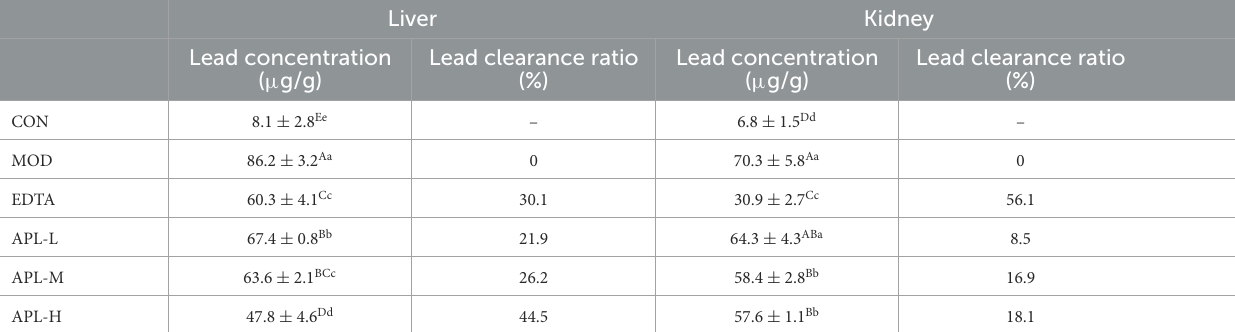
TABLE 3 APL-elicited inhibition of rise in lead concentration and increase of lead clearance ratio in the liver and kidneys following lead